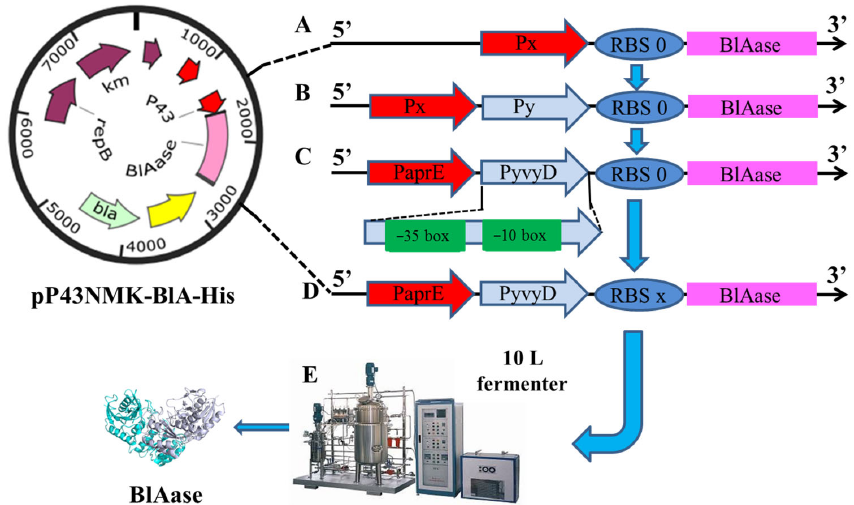
Figure 2. Vector construction with improved expression elements: ( A ) replacing the P43 promoter with a single strong promoter; ( B ) schematic diagram of the construction of dual-promoter systems; ( C ) optimization of core regions of the PyvyD promoter; ( D ) modification of RBS sequence from BlAase; ( E ) high ‐ cell density culture in a 10 L fermenter. Px and Py represent different promoters; RBSx represents different RBS sequences; the − 35 box and − 10 box represent the core regions of the promoter.